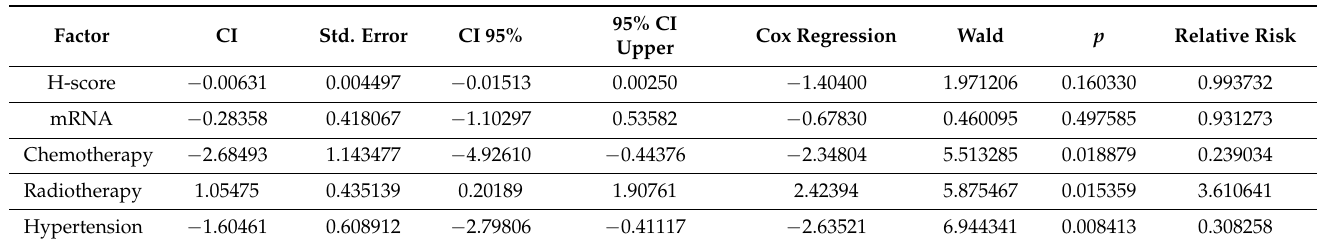
Table 4. Multiple Cox regression model for the group of 48 patients: significant predictors of hazard. Analysis of impact on OS of both ZNF-281 H-score and mRNA with adjustments for all clinical